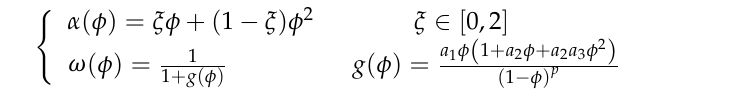
Figure 2. Schematic illustration of sharp ( 𝛤 , left) and diffusive ( ℬ , right) crack topology in a 2D solid 𝛺 with its external boundary ∂𝛺 . The external boundary ∂𝛺 can be divided into two parts: ∂𝛺 (cid:3047) and ∂𝛺 (cid:3048) , with ∂𝛺 (cid:3047) ∩ ∂𝛺 (cid:3048) = ∅ and ∂𝛺 (cid:3047) ∪ ∂𝛺 (cid:3048) = ∂𝛺 , in which it is given displacements 𝒖 ∗ for ∂𝛺 (cid:3048) and tractions 𝒕 ∗ for ∂𝛺 (cid:3047) , respectively. The outward unit normal vector of external boundary ∂𝛺 is denoted as 𝒏 .